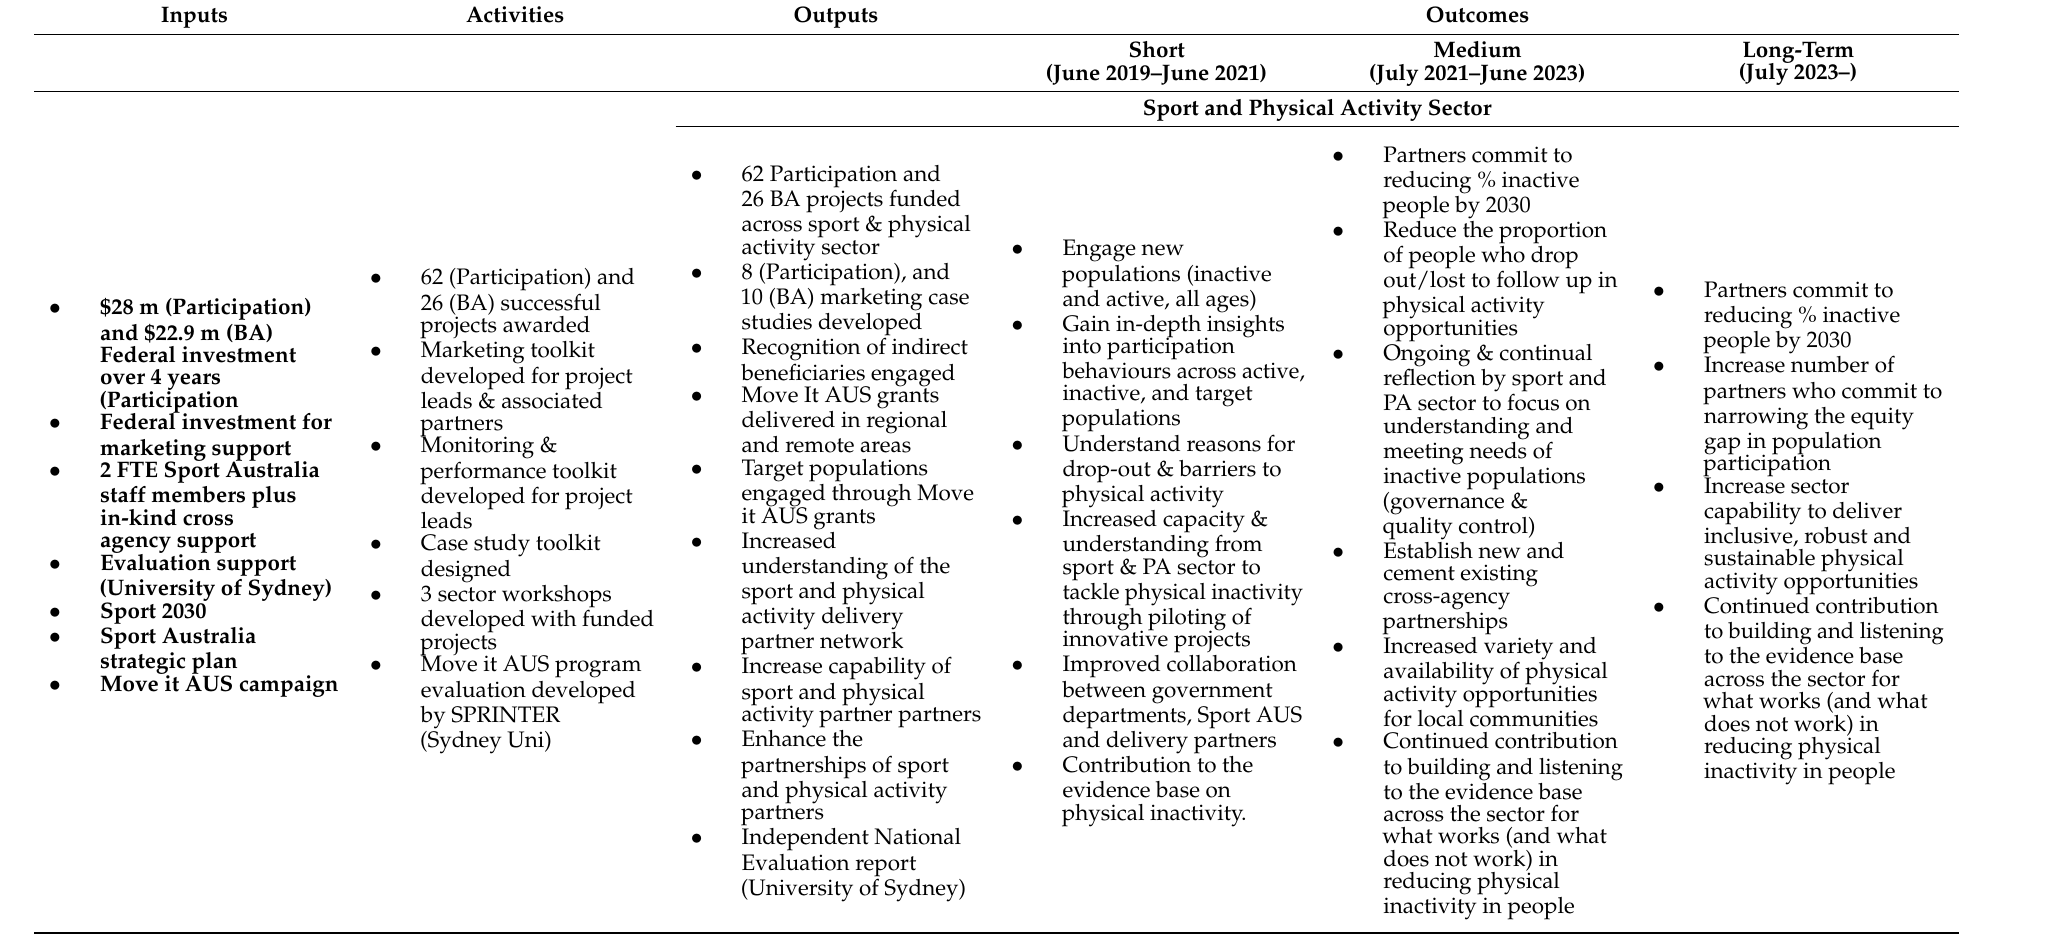
Table 1. Sport Australia Move It AUS Participation and Better Ageing (BA) Logic